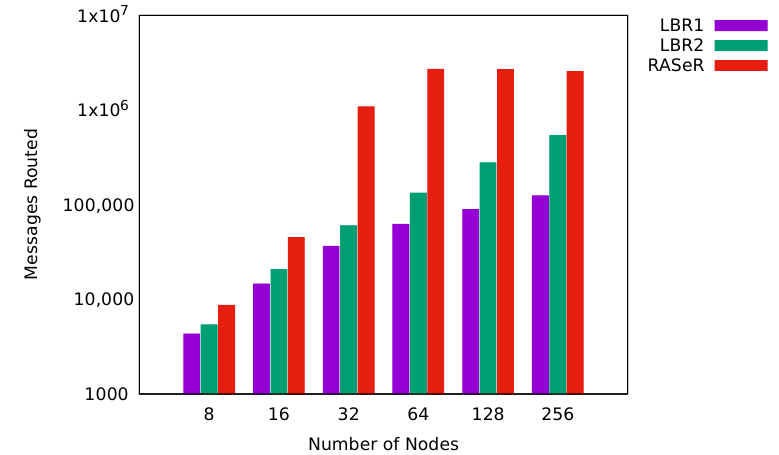
Figure 3. Number of messages routed towards the sink. Results for a maximum velocity of 20 m/s. Note the logarithmic scale on the y